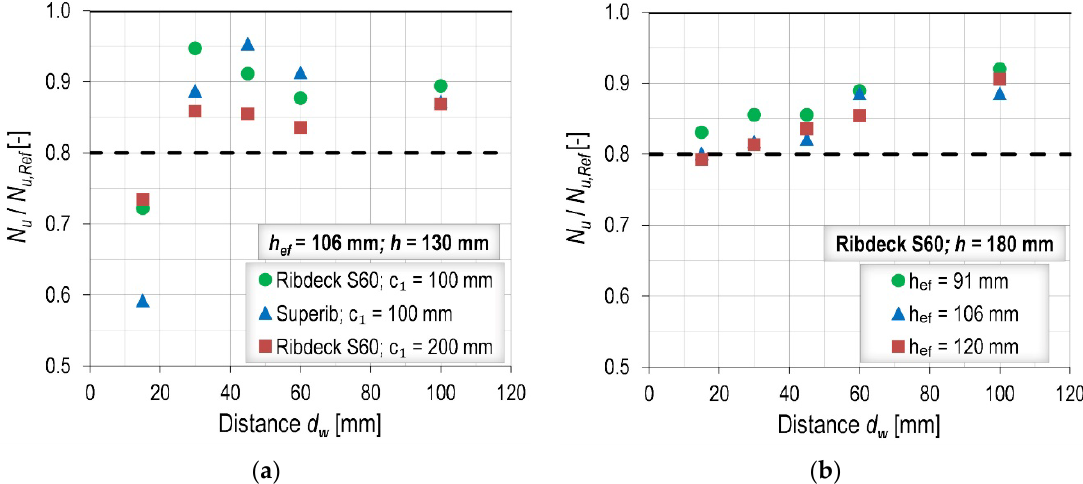
Figure 8. Numerical results of Series 1 for: ( a ) the embedment depth h ef = 106 mm; and ( b ) the overall member thickness h = 180 mm.